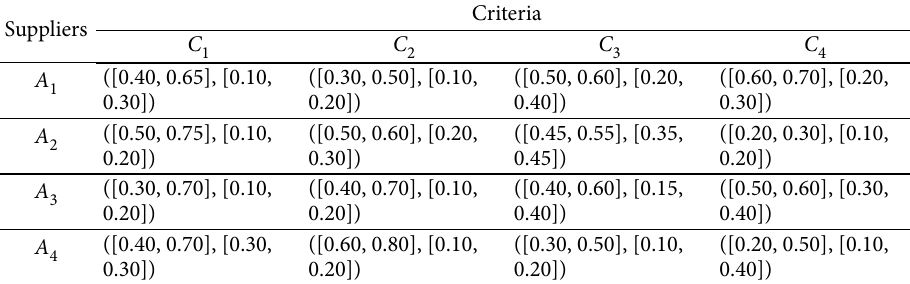
Table 1. Assessments of four green suppliers based on each criterion Supp liers